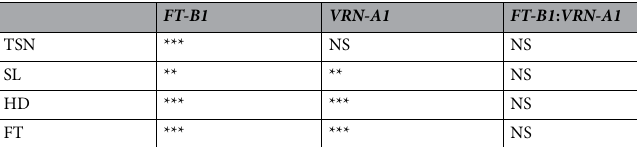
Table 3. P values from two-way ANOVAs for the effects of FT-B1 and VRN-A1 and their interaction ( FT-B1 : VRN-A1 ) on total spikelet number (TSN), spike length (SL), heading date (HD), and flowering time (FT) based on their best linear unbiased estimations (BLUEs). The full ANOVA results are available as Supplementary Table S5 online. * P < 0.05; ** P < 0.01; *** P < 0.001; NS, P > 0.05.